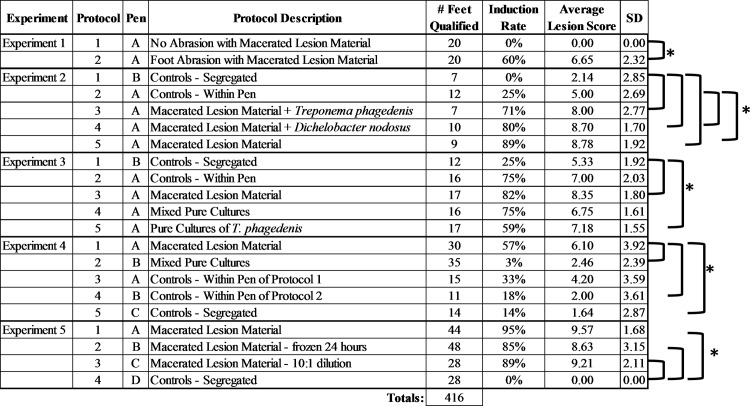
A summary of each protocol within the five experiments.The pen designations denote whether animals were housed within the same pen or separate pens and the letters may designate different pens across experiments. The number of feet qualified refers to the number of feet enrolled in each protocol that retained a wrap throughout the length of the study and did not receive topical or systemic antibiotics during the trial period. The induction rate is the percentage of feet that had a macroscopic lesion score of 7 or greater. The brackets denote statistical significance between groups with alpha = .05 and a correction for multiple testing.